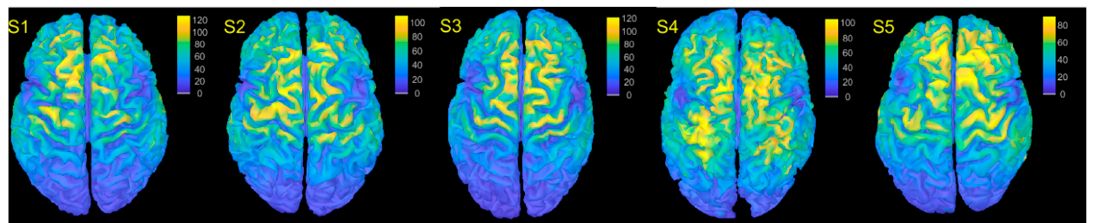
Figure 1. E-fields for all subjects. Warm colors indicate high values, while cold indicate low values. The color scale is not consistent across subjects for visualization purposes.